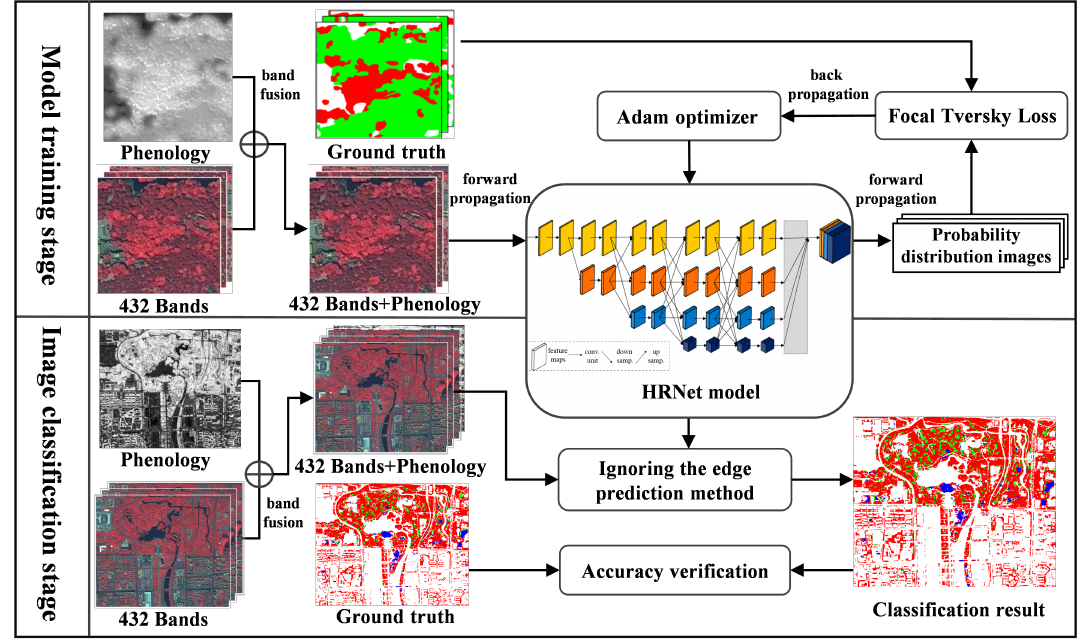
Figure 3. Experimental flow